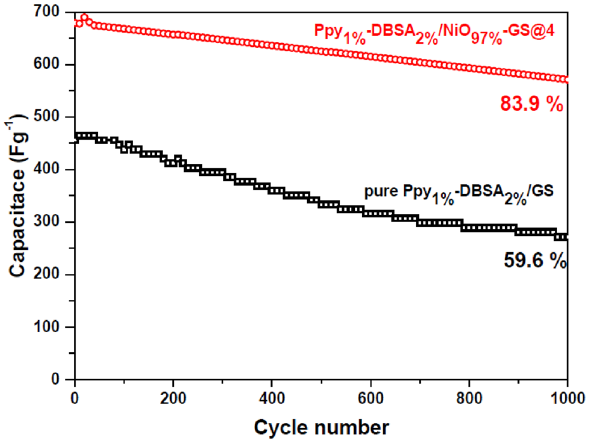
Figure 9. Cycling stability measurement of the pure Ppy 1% -DBSA 2% /GS and Ppy 1% -DBSA 2% /NiO 97% -GS@4 electrodes at 1 A g −1 for 1000